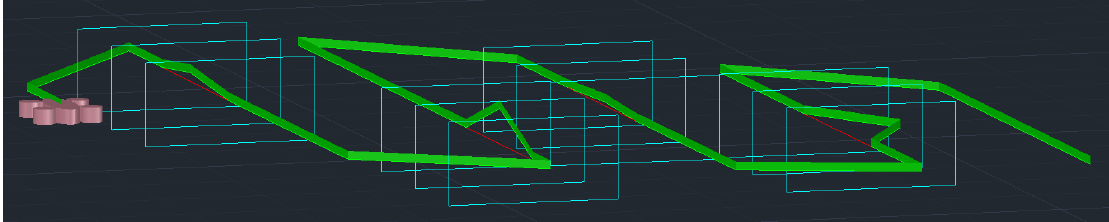
Figure 18. Total trajectory path at the end of the